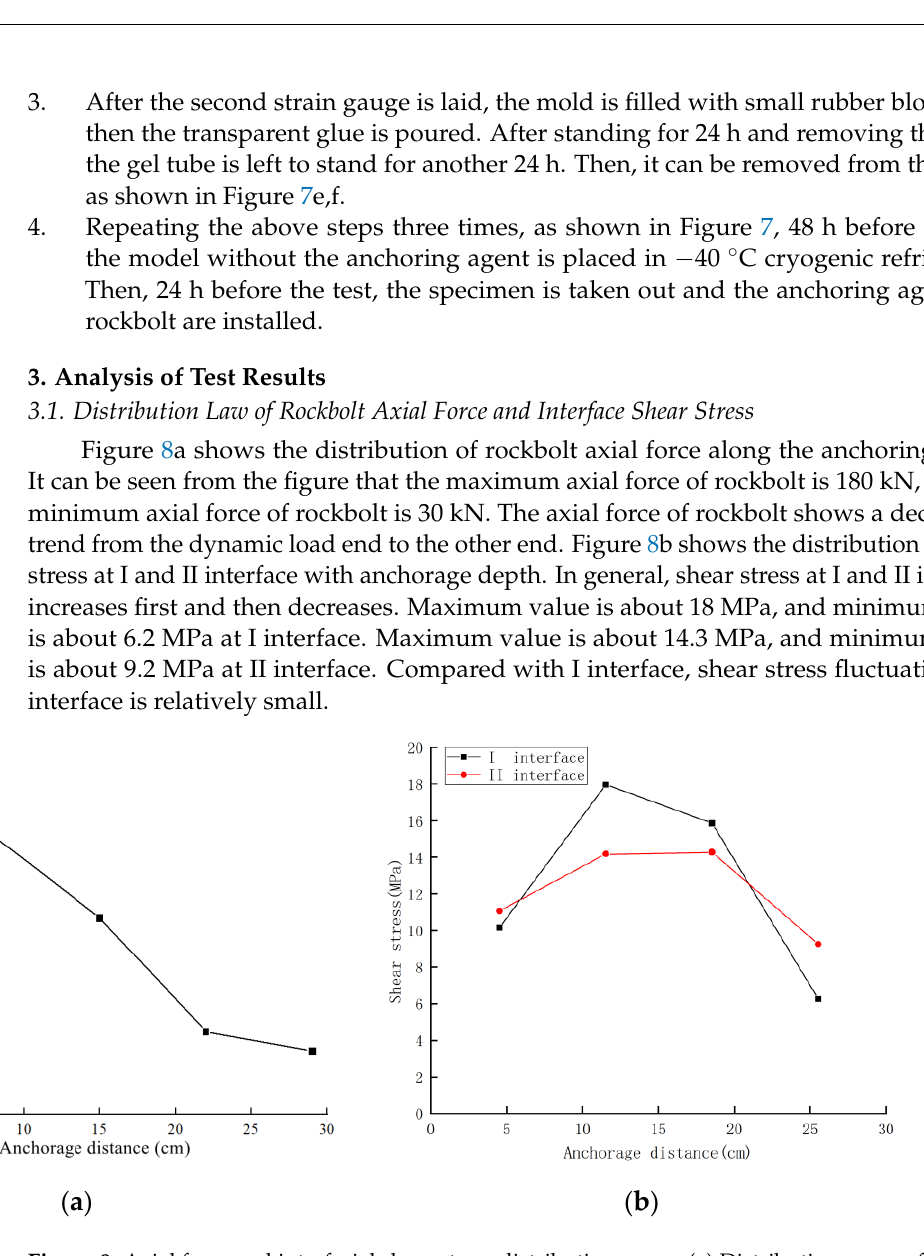
Figure 8. Axial force and interfacial shear stress distribution curve. ( a ) Distribution curve of rockbolt axial force ( b ) Distribution curve of shear stress.